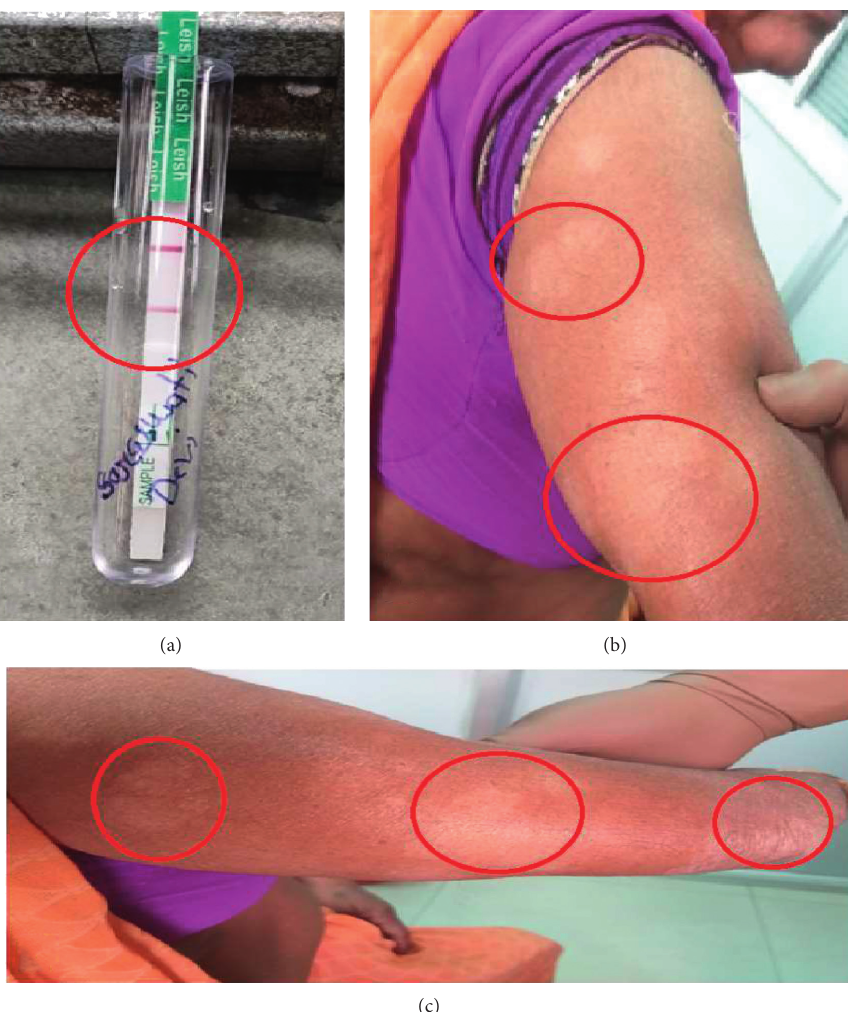
Figure 1: a) rK39 rapid card test (positive result). (b) and (c) Multiple hypopigmented lesions in the extensor aspect of upper